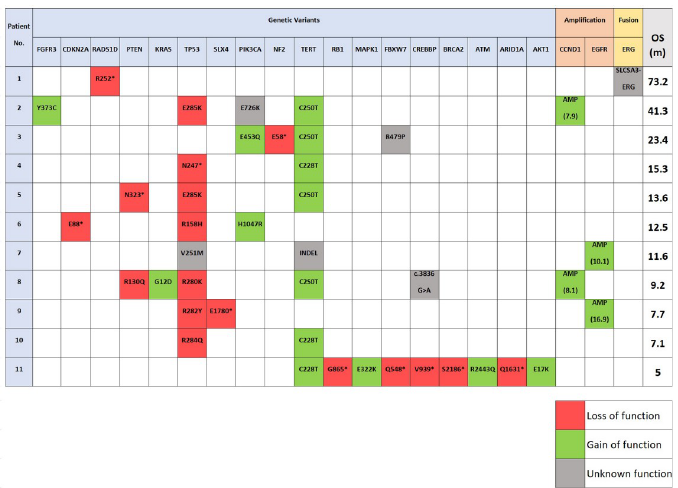
Fig 3. The molecular heatmap of the genomic alterations and survival durations arranged based on patient number. Abbreviations: No., number; AMP, amplification (number of copies); OS, overall survival; m, months; � , termination (stop)